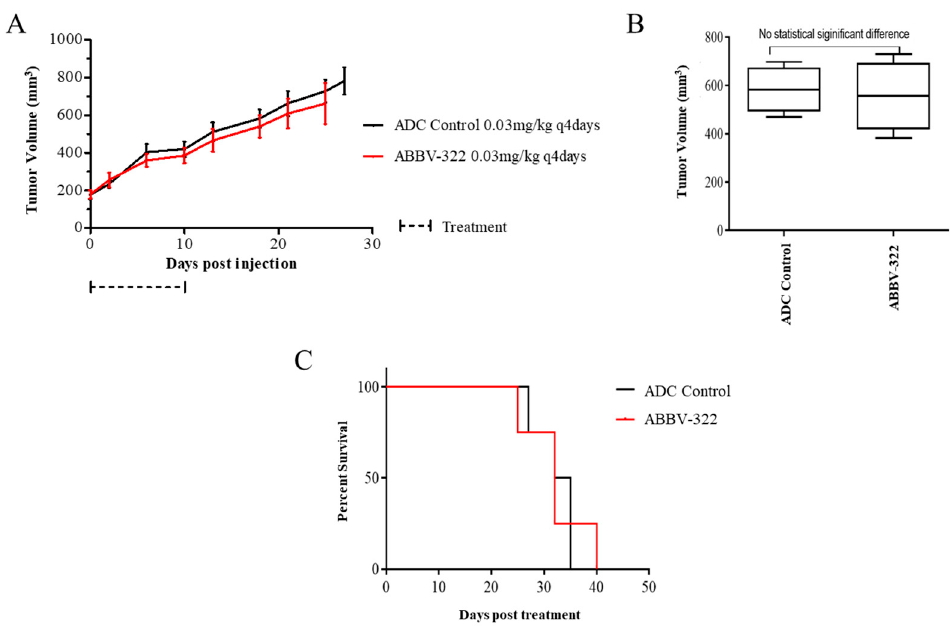
Figure 5. Tumor growth response and survival curves for the mAb806 epitope negative biphasic mesothelioma PDX model (MPM36). The treatments were administered at the doses indicated in the figure. ( A ) The mAb806 IHC negative PDX model demonstrated no significant tumor growth suppression of ABBV-322 compared to the ADC control group. ( B ) The differences in tumor columns between the 2 groups on day 21 post-treatment commencement were found to be nonsignificant ( p = 0.7649, two-sided). ( C ) The survival curves showed no significant differences between the different treatment groups.